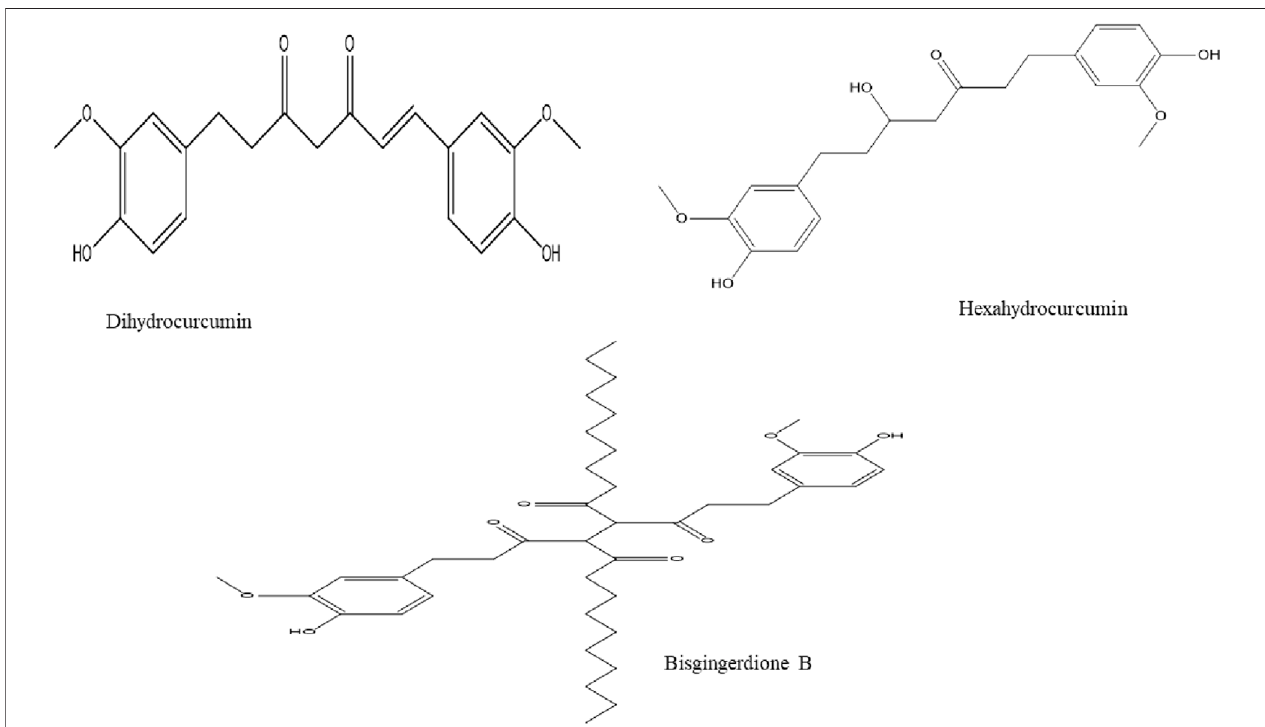
FIGURE 1 | Chemical structures of diarylheptanoids compound isolated from ginger.